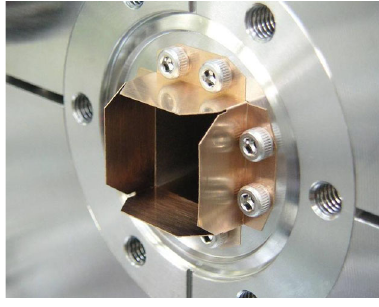
detector.FIG. 12. Photograph of the flange gap finger.